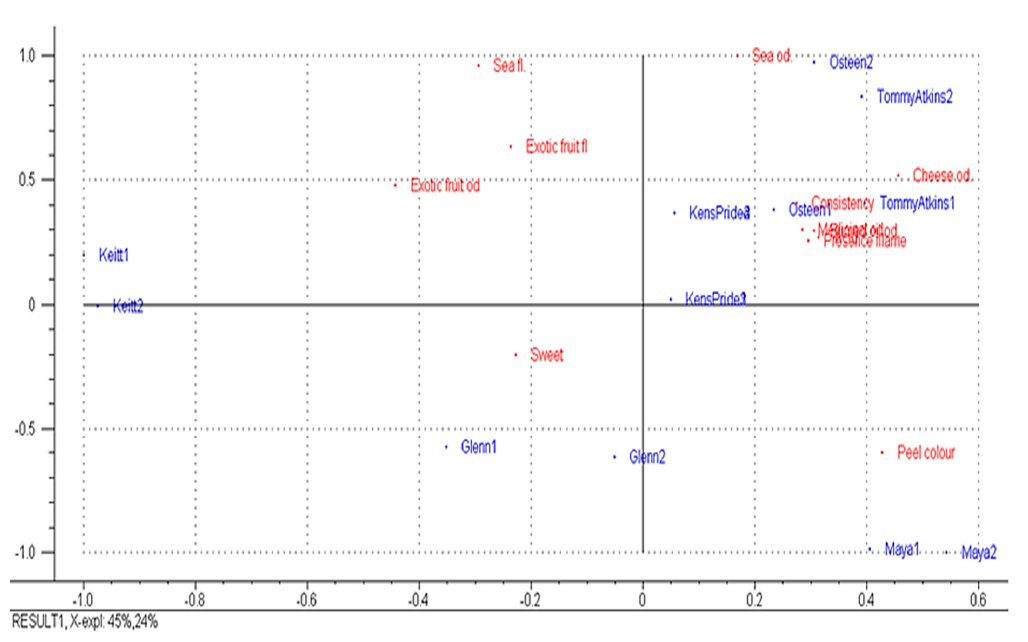
Figure 2. Bi-plot of six mango fruit varieties from sensory descriptors during the first and the second year of study.